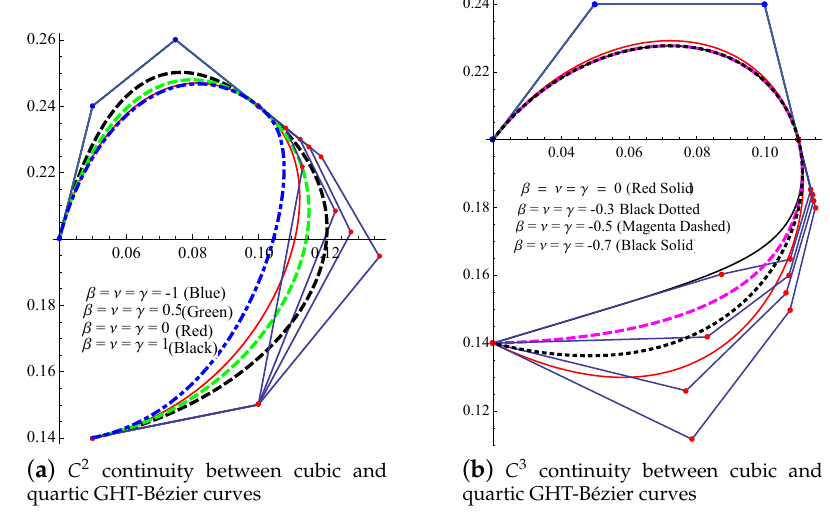
Figure 7. C 2 and C 3 continuity between GHT-Bézier curves having different degrees. ( a ) C 2 continuity between cubic and quartic GHT-Bézier curves; ( b ) C 3 continuity between cubic and quartic GHT-Bézier